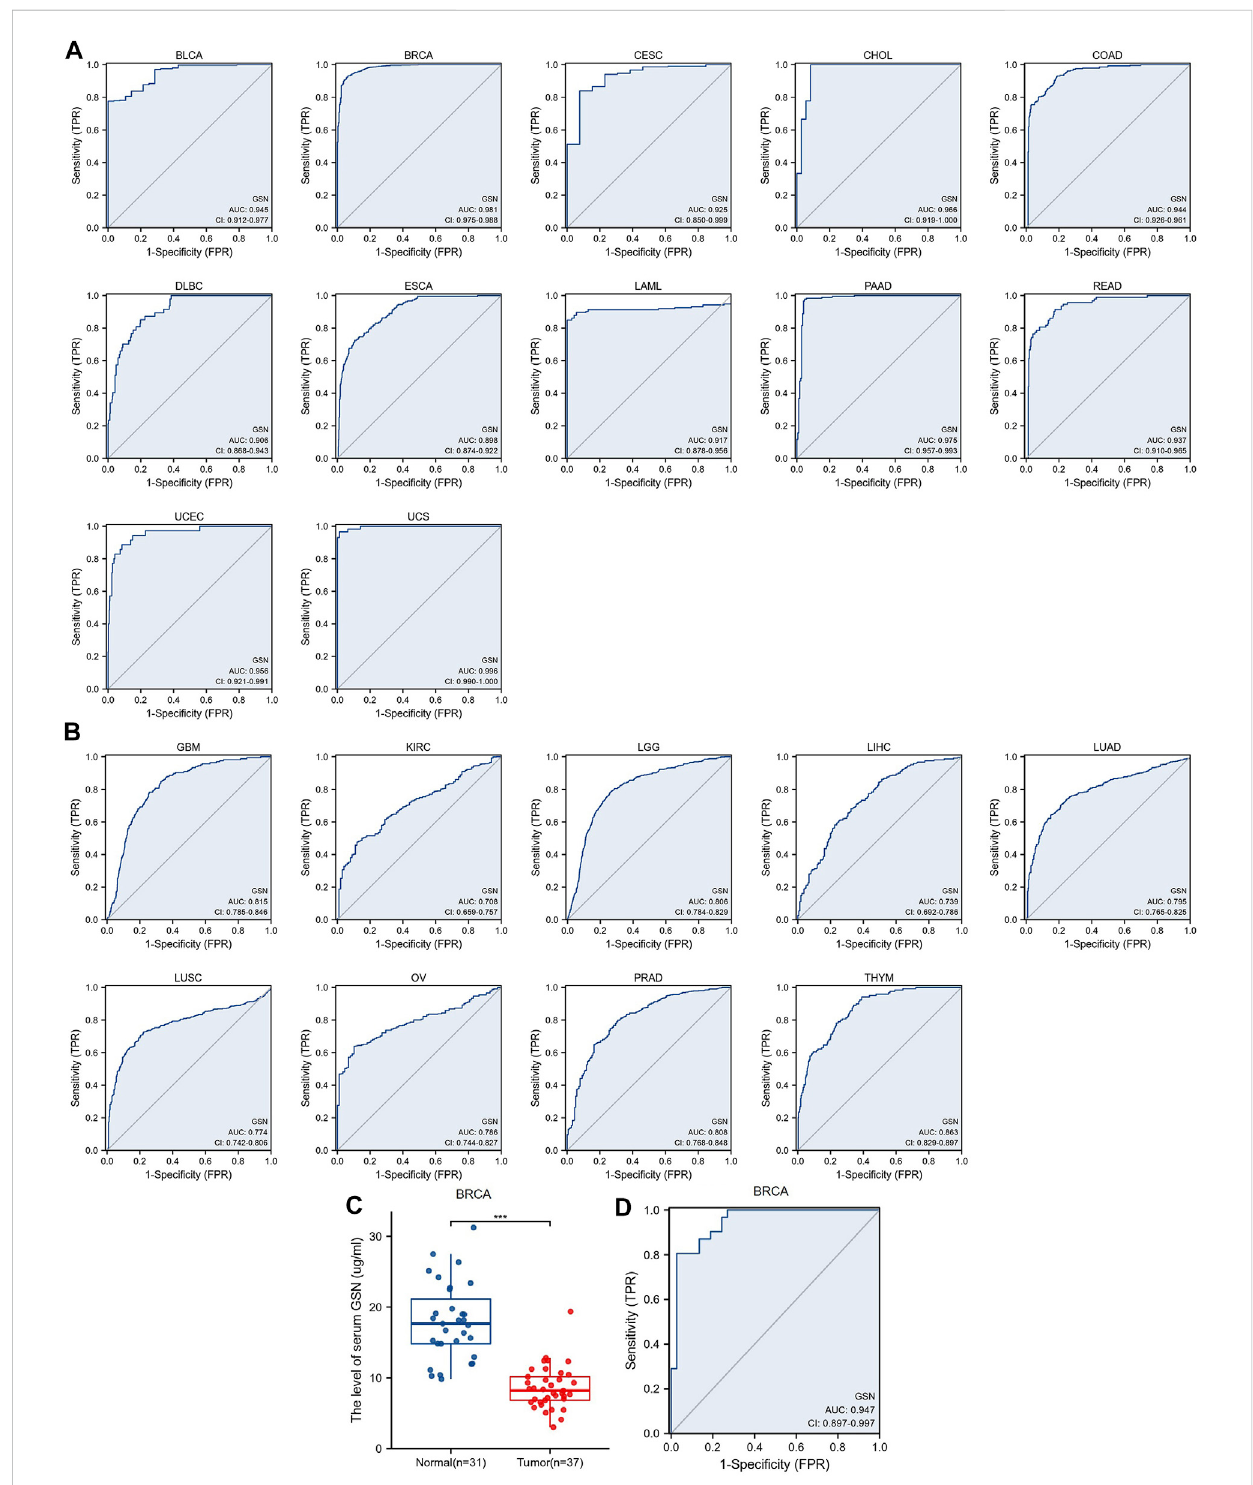
FIGURE 5 Receiver operating characteristic (ROC) curve of GSN expression in pan-carcinoma and determination of serum GSN in breast cancer patients. (A) GSN expresses cancers of good diagnostic value (AUC > 0.9), including BLCA, BRCA, CESC, CHOL, COAD, DLBC, ESCA, LAML, PAAD, READ, UCEC, UCS. (B) GSN expresses cancer with some diagnostic value (AUC > 0.7), including GBM, KIRC, LGG, LIHC, LUAD, LUSC, OV, PRAD, THYM. (C) GSN protein content in serum of breast cancer patients. (D) Diagnostic ROC curve of serum GSN for breast cancer. (*** p <